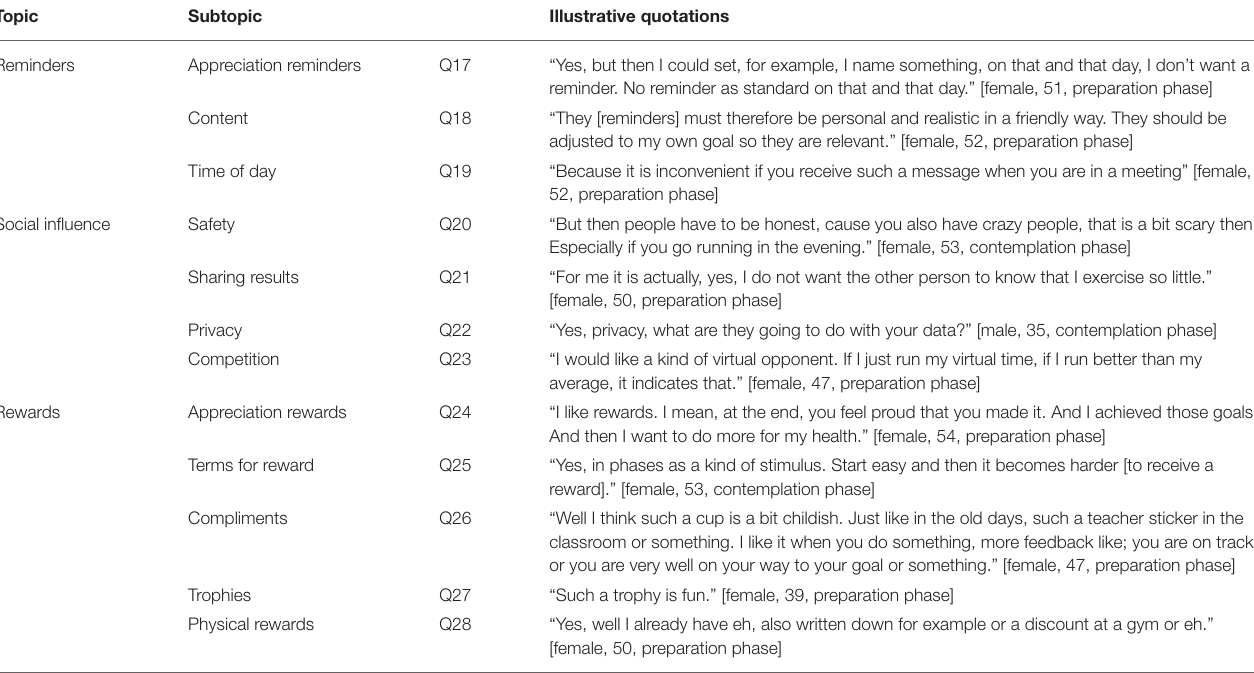
TABLE 5 | Illustrative quotations reminders, social influence, and